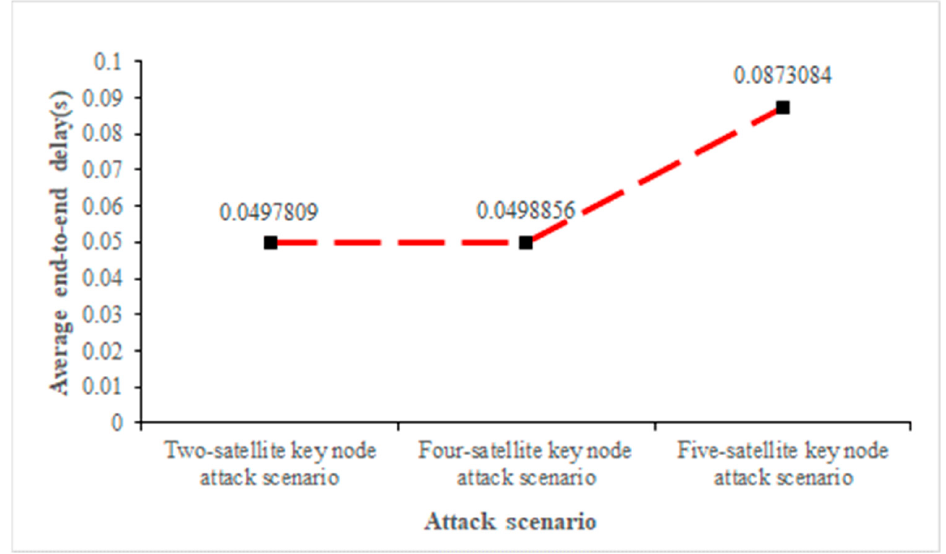
Figure 11. Average end–to–end delay under three attack scenarios.